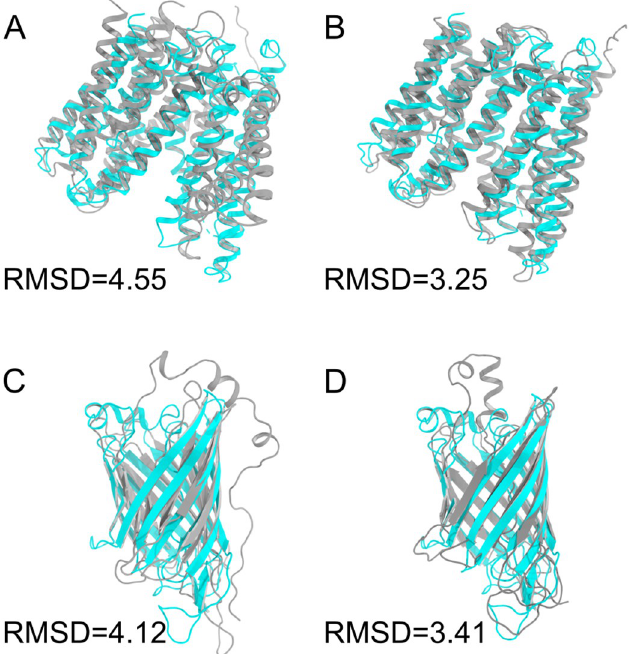
Fig 7. The MCP-incorporated CM predictions improved the protein structure prediction accuracy for the two representative cases. (A), (B) The predicted protein structures for 5aym using the predicted CMs without and with MCP incorporated, respectively. The crystal structure was shown in cyan and the predicted structures were shown in grey. (C-D) Similar to (A-B), but for the protein structure